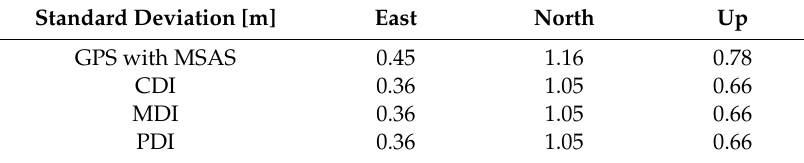
Table 2. Standard deviation of CDI, MDI, and PDI for multi-GNSS and multi-SBAS integration.